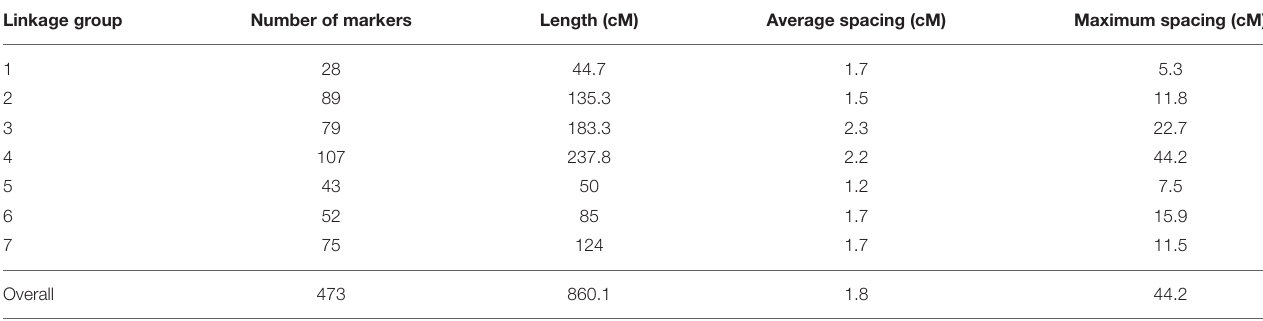
TABLE 1 | Descriptive statistics of the genotyping-by-sequencing-based genetic linkage map developed from 68 F 2 individuals of perennial ryegrass segregating for self-compatibility. Linkage